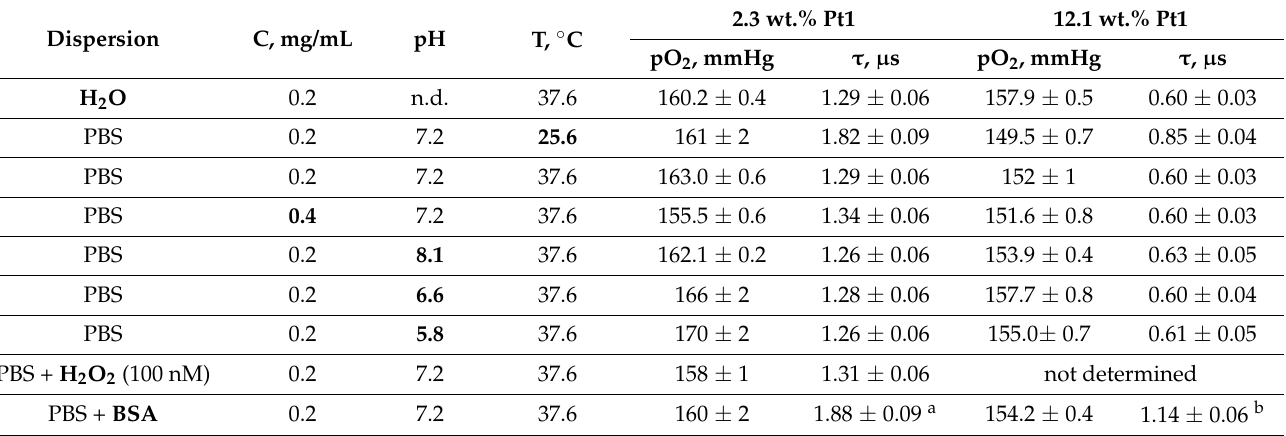
Table 2. Luminescence lifetimes of aerated dispersions of Pt1@PCL- b -PEG (2.3 and 12.1 wt.%) at various external